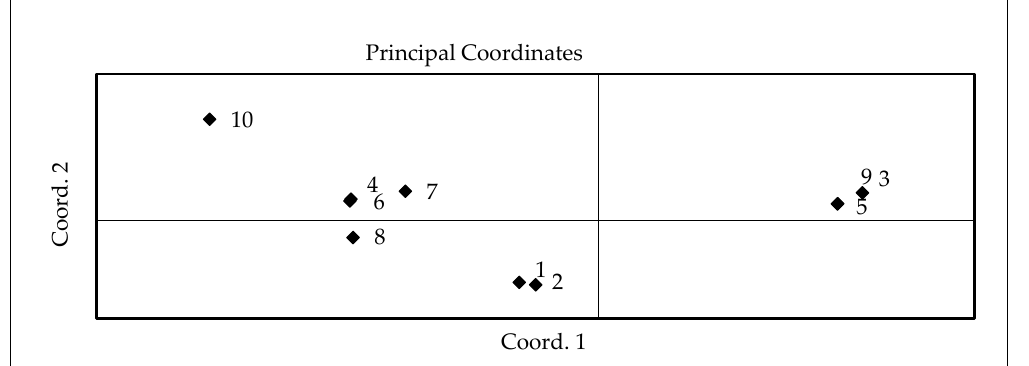
Figure 3. Scatter plot of different basil cultivars according to the results of principled coordinate analysis (PCoA) of the essential oil accumulation in 2017 – 2018. Basil cultivars: 1 — Sweet Genovese; 2 — Toscano; 3 — Classic Italiano; 4 — Siam Queen; 5 — Fino Verde; 6 — Cinnamon; 7 — Compact; 8 — Purple Opaal; 9 — Rosie; 10 — Holly.